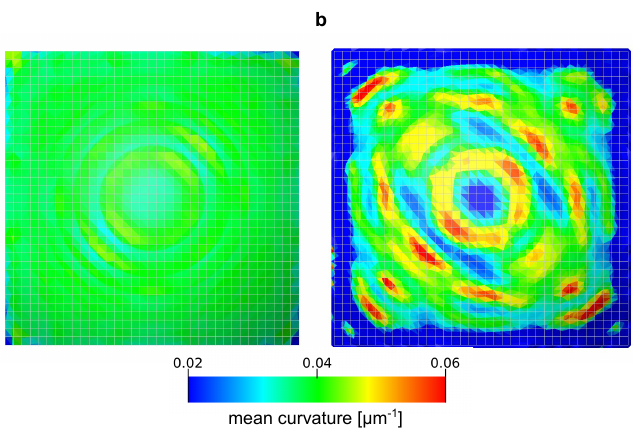
Figure 9. Distribution of computed mean curvature on ( a ) the simulated surface and ( b ) the smoothed surface for θ = 45 ◦ . The grid size of these surfaces are 1 µ m/voxel. The analytical value of mean curvature for this case is κ m = 0.04 µ m − 1 and uniform everywhere. We see large errors near the three-phase contact line.